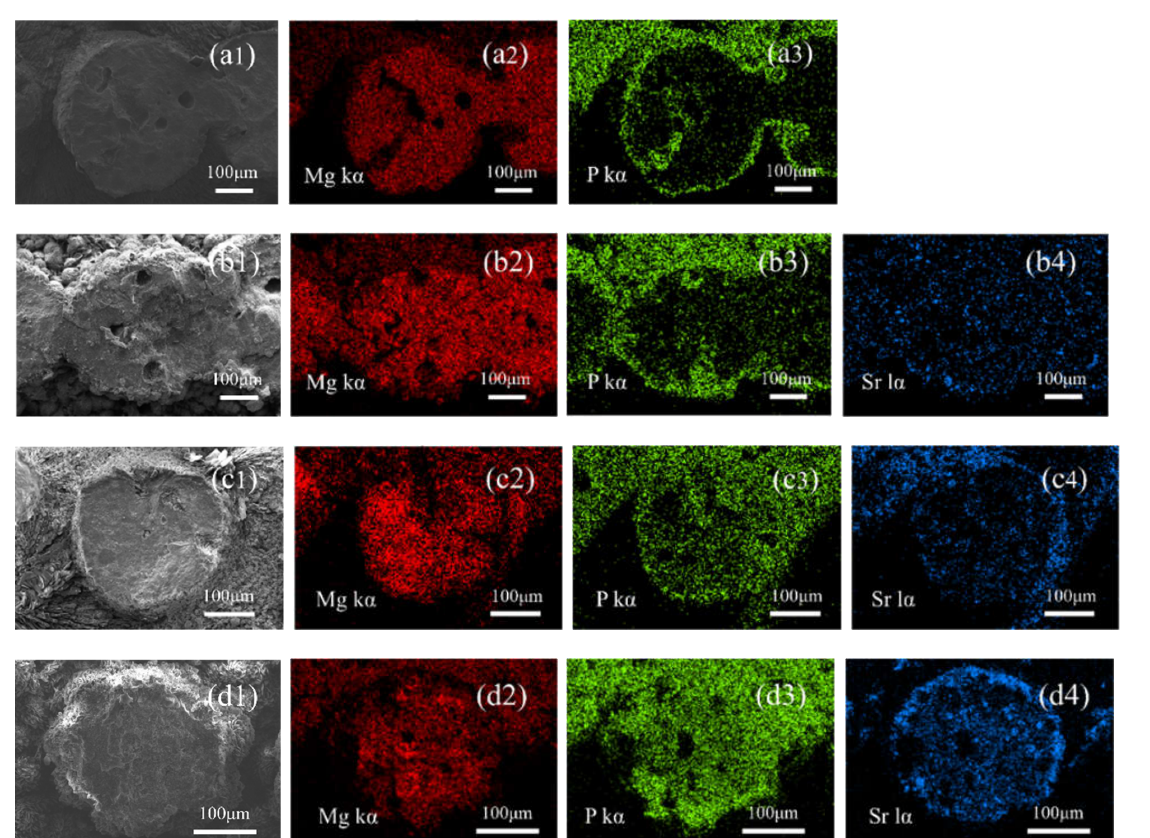
Figure 5. Cross-sectional morphologies and elemental mappings of porous composite scaffolds S0, S1, S3, and S5 ( a – d , respectively). SEM images ( a1 , b1 , c1 , d1 ); Mg element ( a2 , b2 , c2 , d2 ); P element ( a3 , b3 , c3 , d3 ); and Sr element ( b4 , c4 , d4 ).